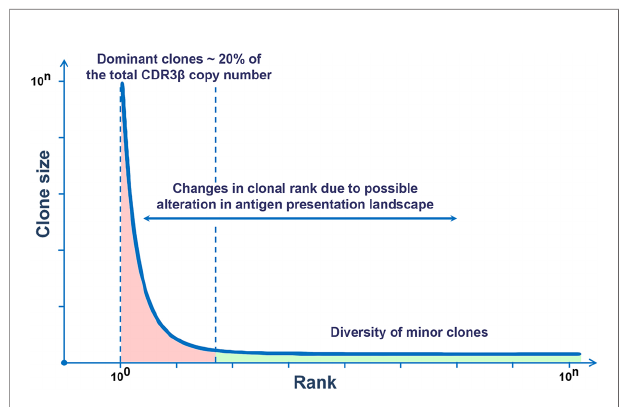
FIGURE 1 | Rank – size frequency distribution follows a power-law distribution. This graph demonstrates the ranking of TCR clones by sizes. To the left, there are few dominant clones (red), and to the right, there is the long tail re fl ecting a multitude of minor clones